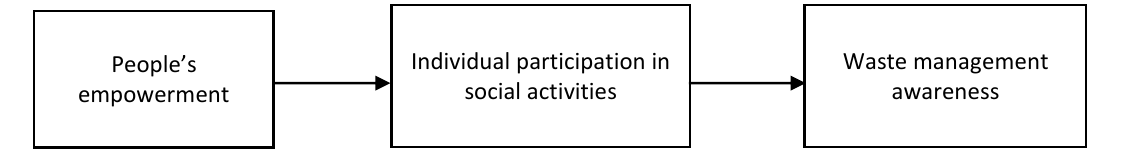
Fig. 2: Framework of the current study